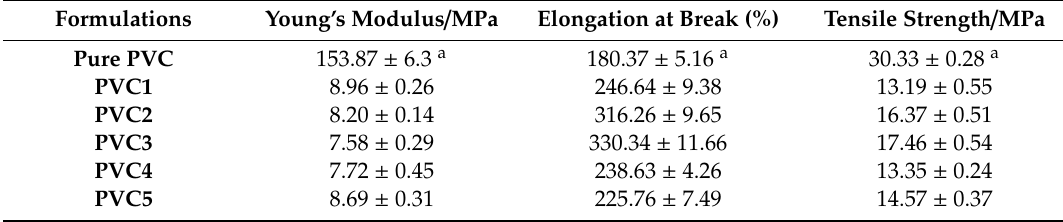
Table 2. Main results of Young’s modulus, elongation at break, and tensile strength determined at 25 ◦ C.